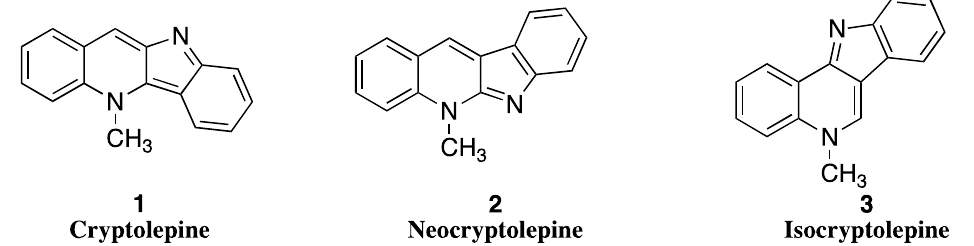
Figure 1. Structures of typical indoloquinolines from Cryptolepis sanguinolenta .